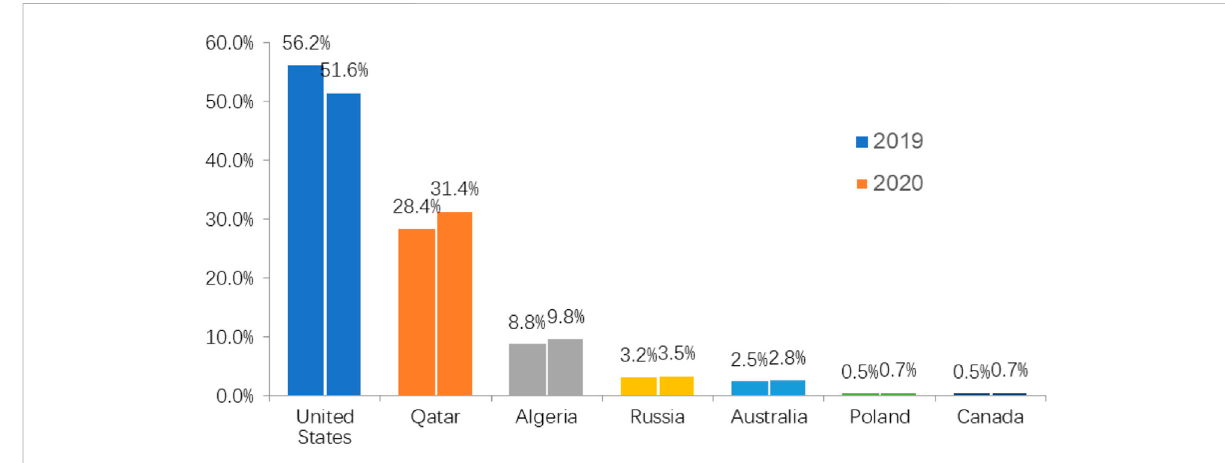
FIGURE 3 Proportion of global helium production from 2019 to 2020 (data from USGS, 2021) (Thor Resources Inc,